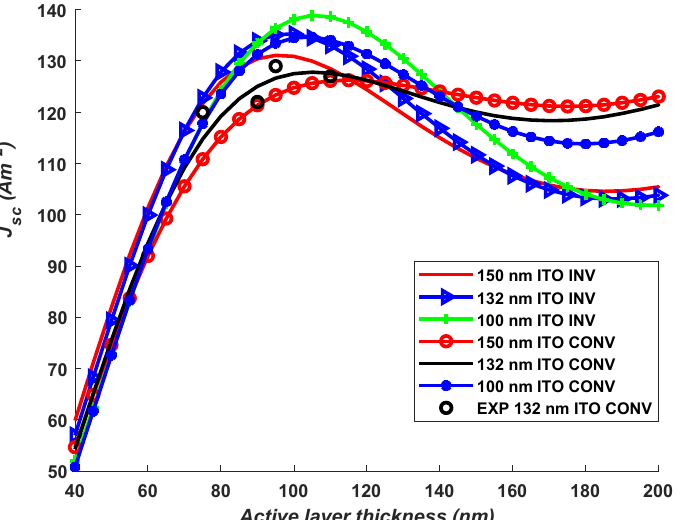
Figure 3. Simulated J SC is plotted for both conventional and inverted OSCs as a function of the active layer thickness for three selected ITO thicknesses of 100 nm, 132 nm, and 150 nm. The experimental results are also plotted for comparison.